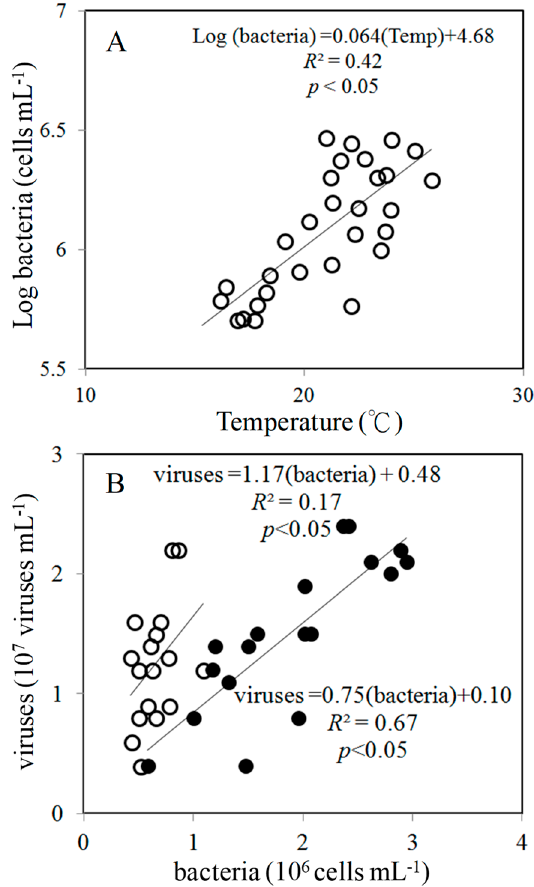
Figure 5. Relationship between temperature and log(bacterial abundance) ( A ) and between viral and bacterial abundance ( B ) during the study period. The solid line is the regression line for all data ( ○ ); ( □ ): the data for transects A–D; ( ■ ): the data for transects E–I.